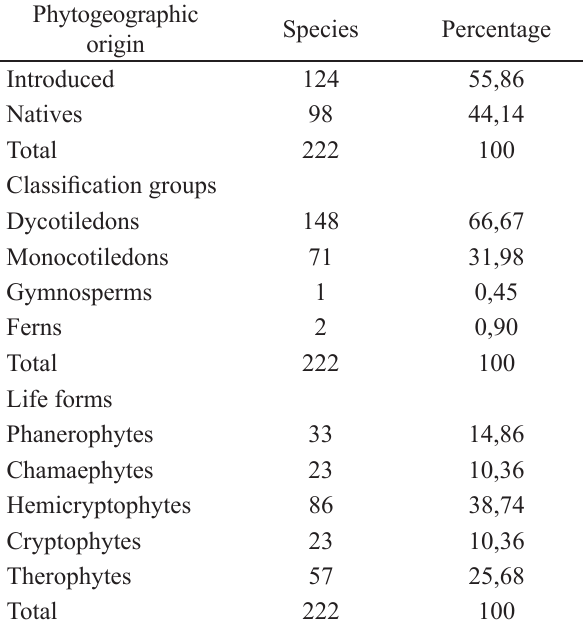
Table 2. Origin, classification and biological spectrum of the flora at the study area.